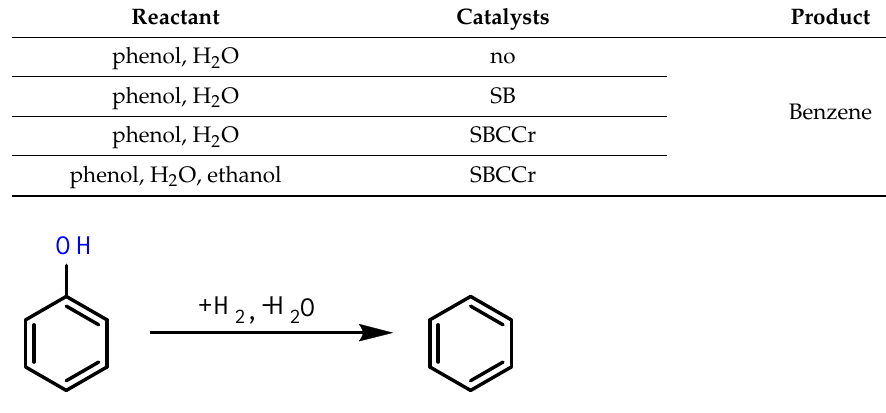
Table 5. New compounds of the phenols under different reaction conditions.